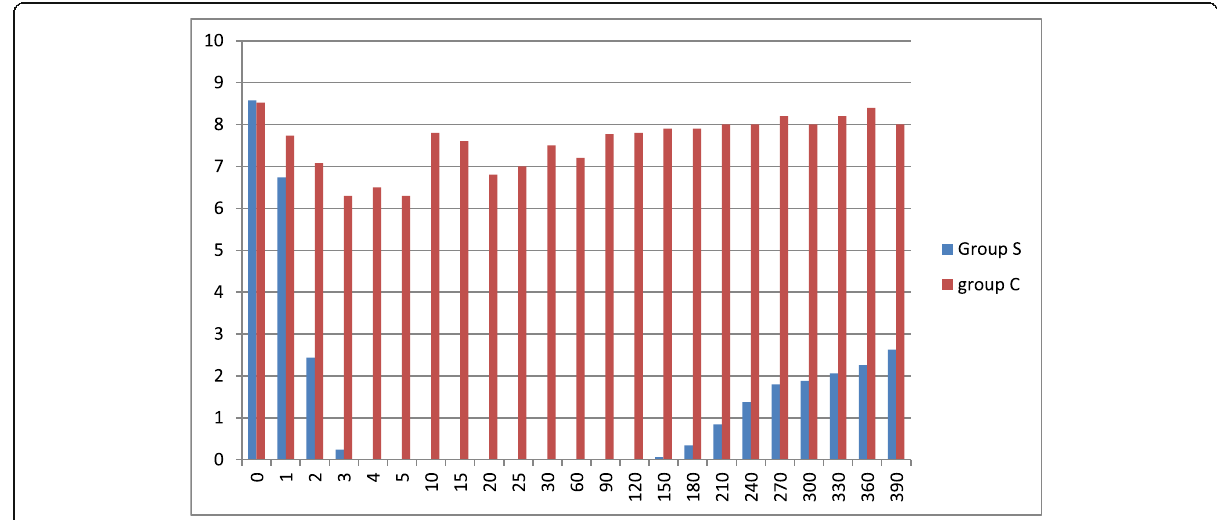
Fig. 2 Comparison of VAS score in two groups. ( x axis represents mean VAS score and y axis represents time duration in